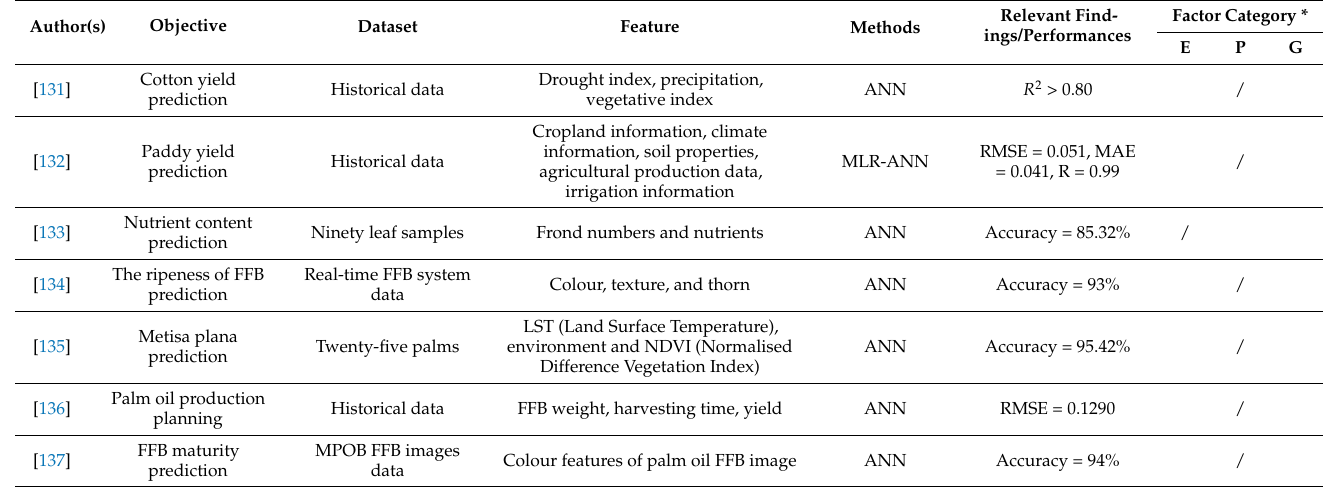
Table 7. ANN prediction of crops and palm